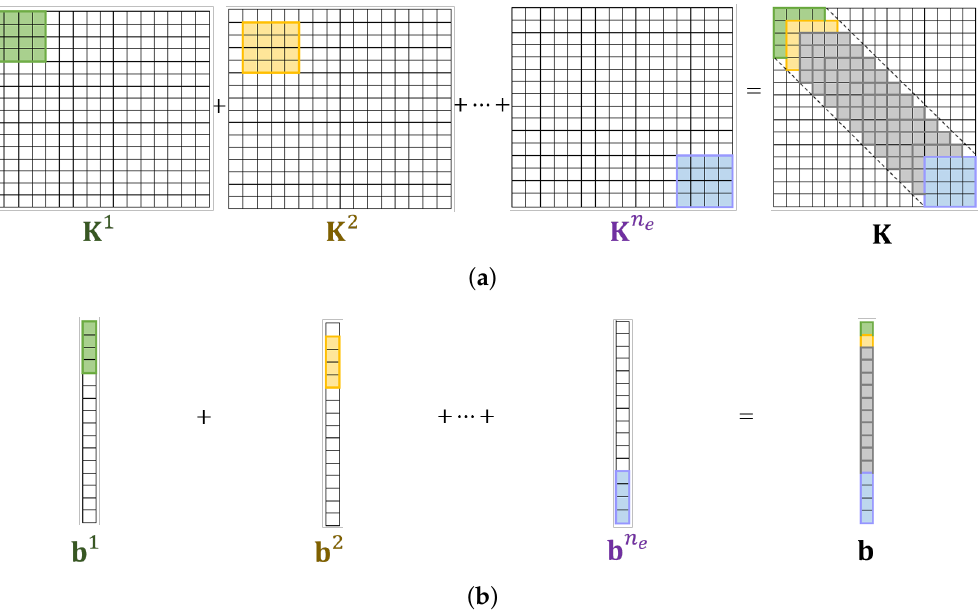
Figure 2. Assembly. The superscript stands for the number of the element. ( a ) Stiffness matrix. ( b ) Load